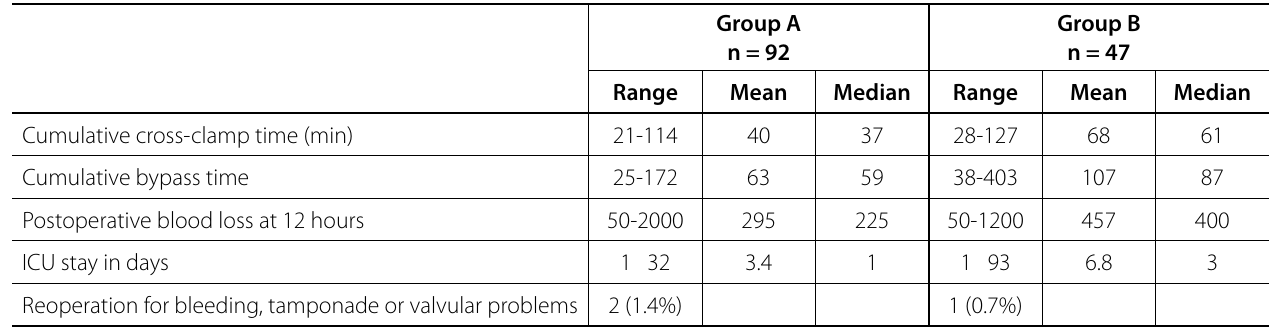
Table 2. Postoperative summary.